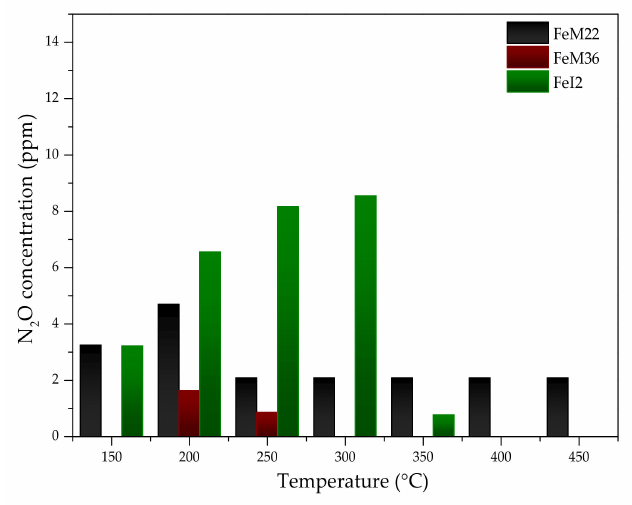
Figure 7. Concentration of N 2 O in the gas mixture during NH 3 -SCR catalytic tests conducted over Fe-MWW